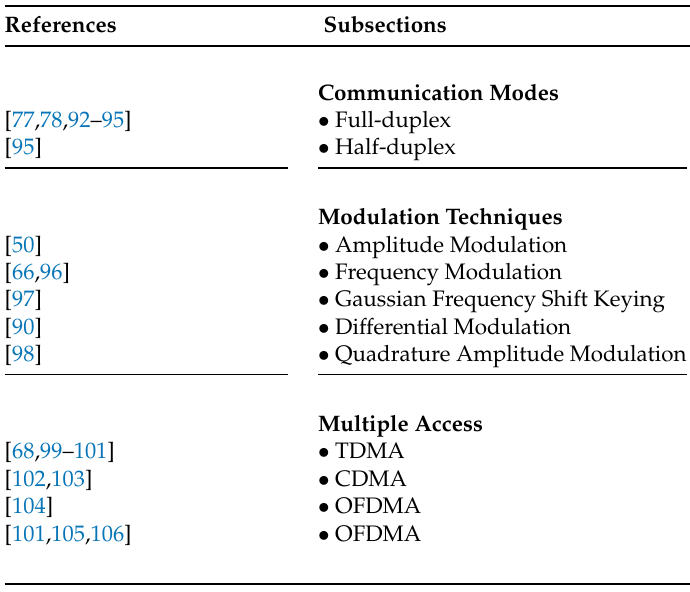
Table 5. BackCom: wireless